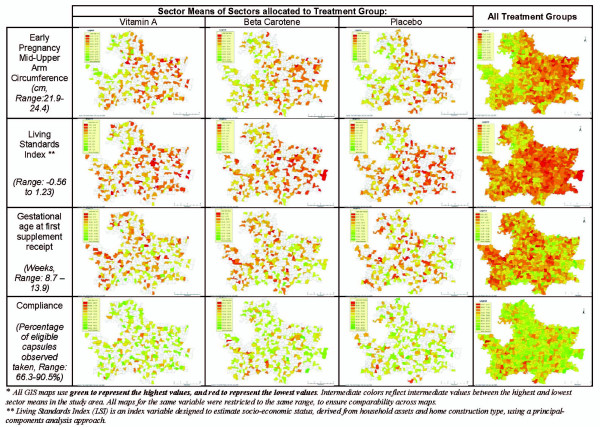
GIS maps of the JiVitA-1 study area, illustrating successful sector-level randomization by displaying sector means of four select characteristics of enrolled women in those sectors (early pregnancy arm circumference, living standards index [14], gestational age at first dose, and dosing compliance throughout the duration of the study).